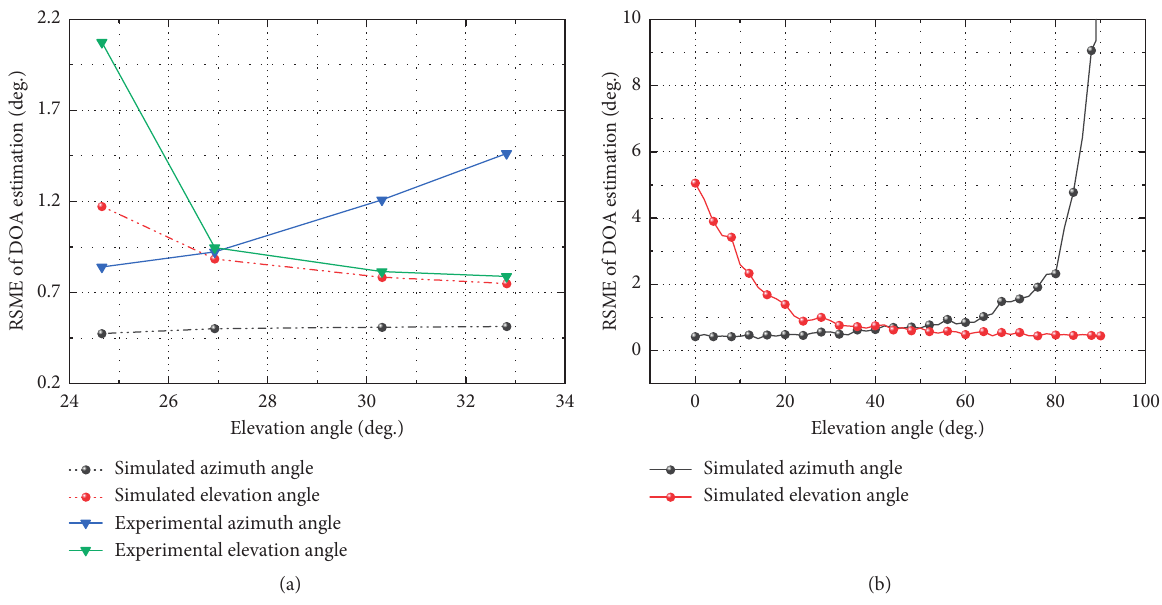
Figure 9: RMSE of DOA estimation under different elevation angles when side length of antenna aperture is 4m and azimuth angle is 168.88 degrees. (a) Comparison between the experimental results and simulation results. (b) Simulation results under elevation angle of 0–90